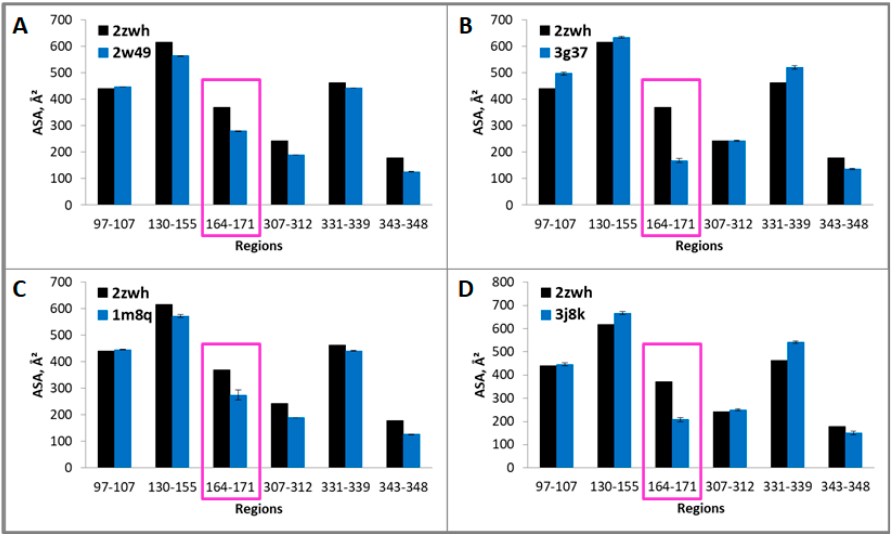
Figure 6. Accessible surface areas of regions 97–107, 130–155, 164–171, 307–312, 331–339, and 343–348 for monomeric (2zwh) and filamentous (2w49—16 monomers ( A ), 3g37—12 monomers ( B ), 1m8q— 14 monomers ( C ), 3j8k—10 monomers ( D )) actin structures. These regions were detected by using